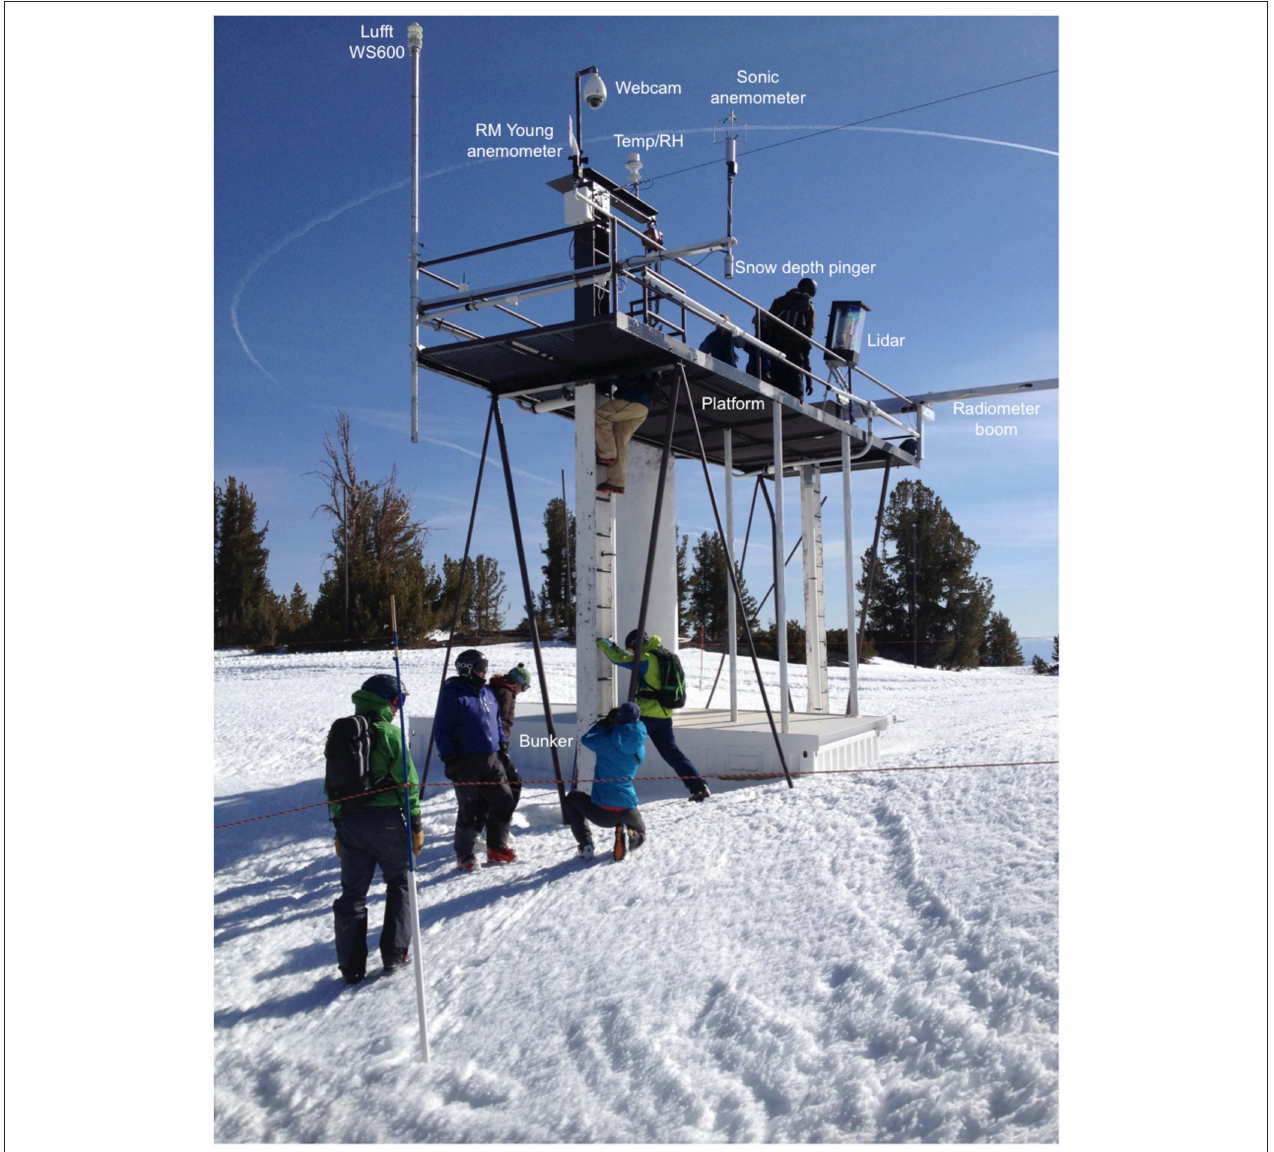
FIGURE 2 | Students exploring CUES. Visible instruments are labeled. Photo courtesy of Chris Heckman.